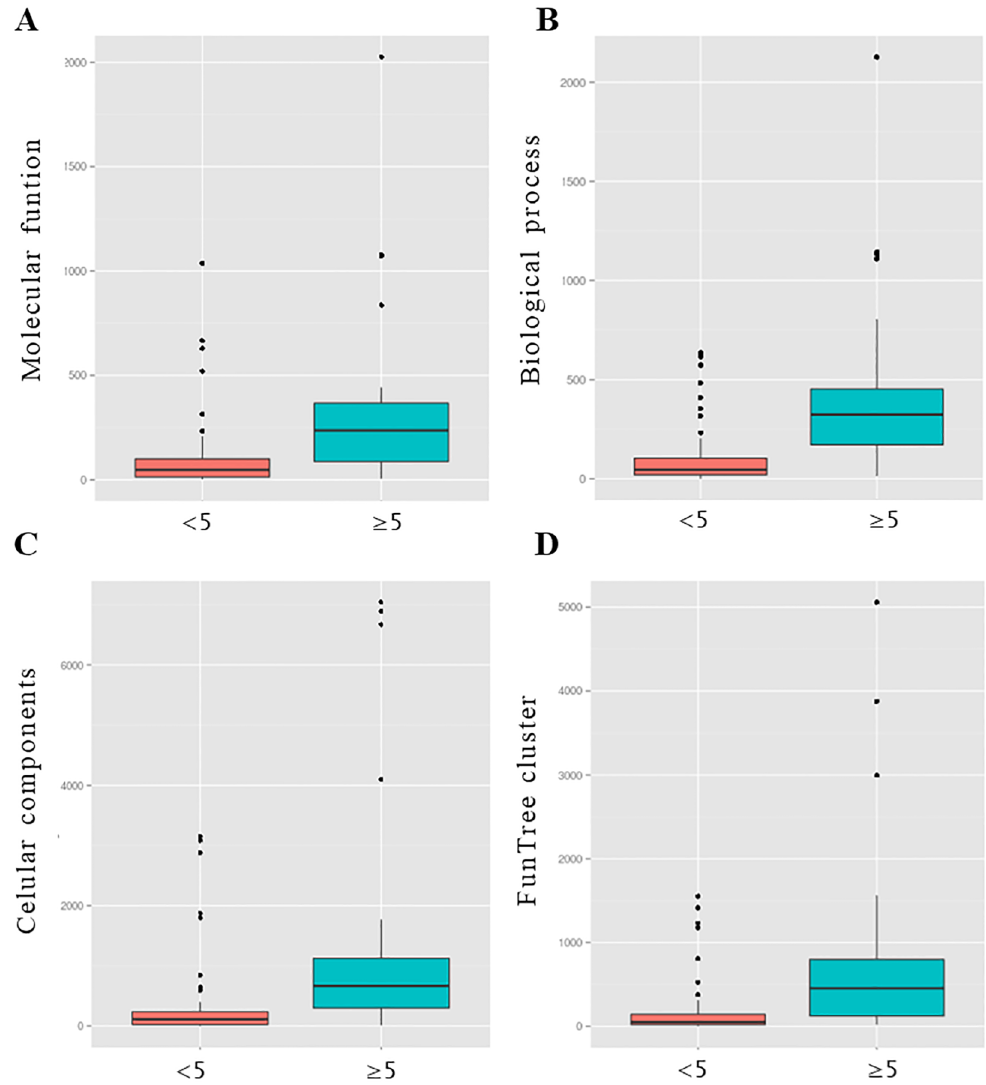
Fig 4. Distribution of number of GO terms associated with folds with more and less than 5 biopeptides. Distributions of different GO terms per each class (Molecular function, Cellular components and Biological process) for proteins showing less than 5 and 5 or more BP (panels a, b, and c). Panel d, shows the same distribution but now using FunTree clusters information. In all the cases it is possible to observe that proteins with more than 5 BPs are functionally more diverse than those proteins with less than 5